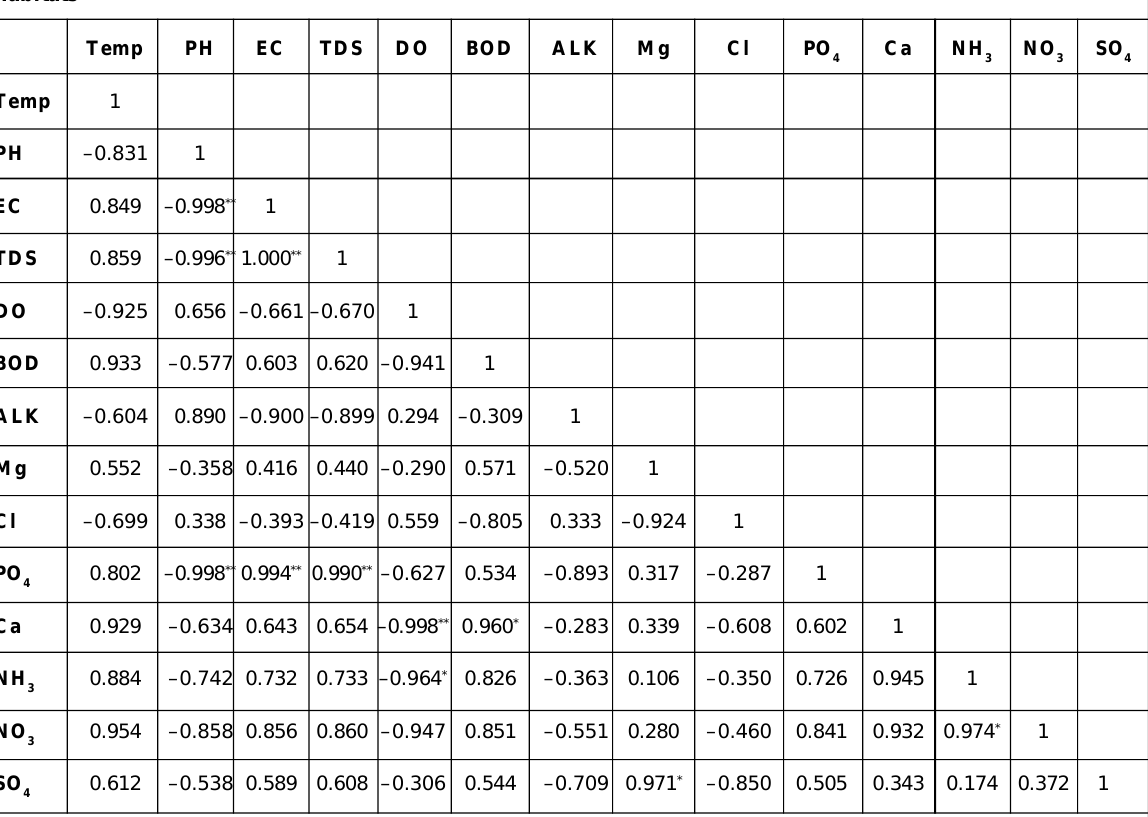
Table 3: Pearson correlation coefficients of physicochemical parameters of Culex quinquefasciatus breeding habitats